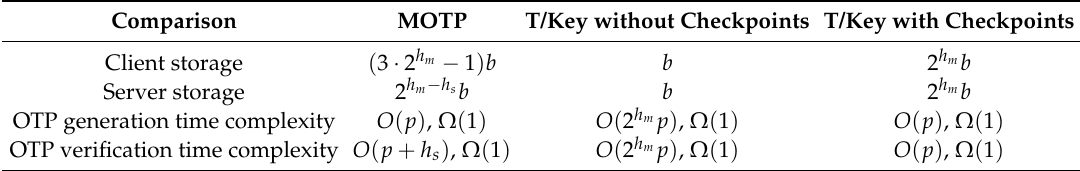
Table 7. MOTP and T/Key space-time complexity comparison (the size of the hash value and nonce is b ). Comparison MOTP T/Key without Checkpoints T/Key with Checkpoints Client